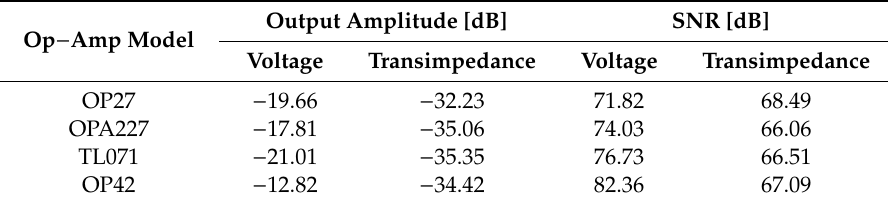
Figure 5. Comparison of the signal level and noise properties of the QTF preamplifier with different operational amplifiers working in voltage and transimpedance modes. Table 2. Measured amplitude of the signal from the sensor and signal-to-noise ratio for the QTF preamplifiers implemented with different operational amplifier models working in transimpedance and voltage configurations.